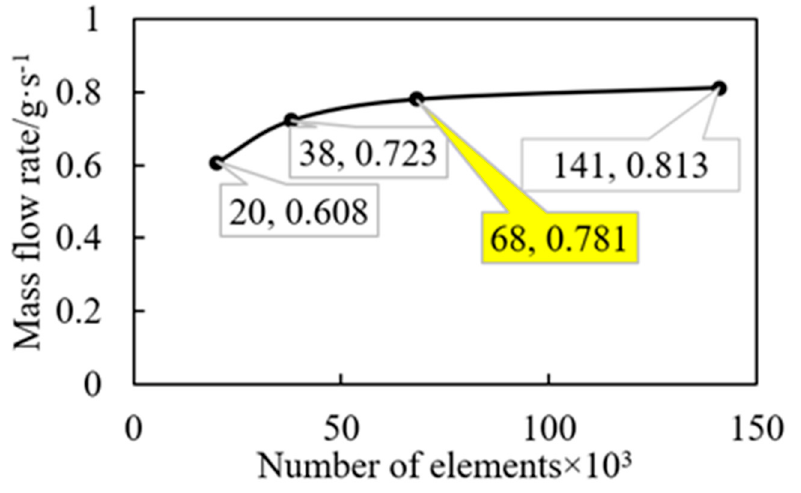
Figure 4. Grid-independence verification.